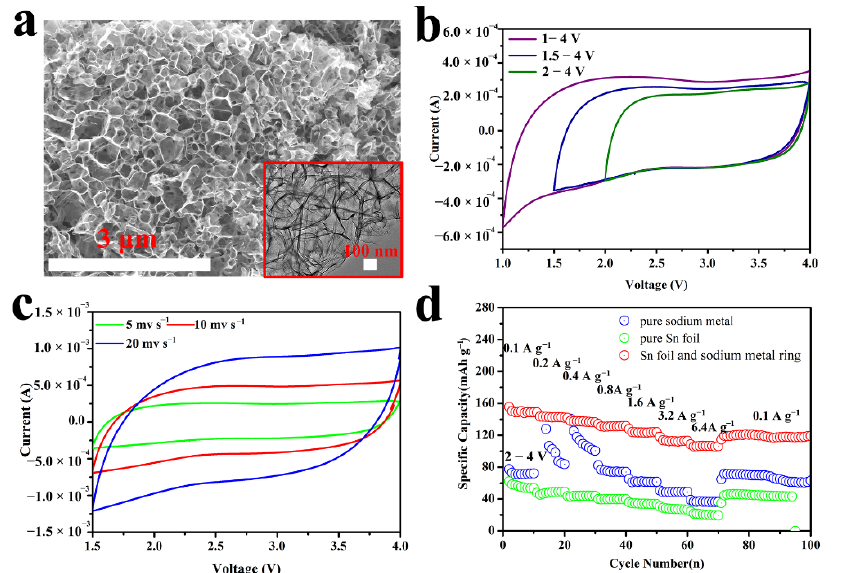
Figure 2. ( a ) The morphology of SCDC tested by FESEM, Raman (in the upper right of Figure 2a) and TEM (in the right bottom of Figure 2a); ( b ) Cyclic voltammetry curves of SCDC vs. Na/Na + in different voltage ranges of 1.0–4.0 V, 1.5–4.0 V and 2.0–4.0 V; ( c ) Cyclic voltammetry curves of SCDC vs. Na/Na + at different scan rate of 5 mV s − 1 , 10 mV s − 1 and 20 mV s − 1 ; ( d ) Comparison of gradient properties for pure Sn foil, pure Na metal disc and sodium-tin alloy anode in situ electrochemical derived from Sn foil inlaid with sodium ring.